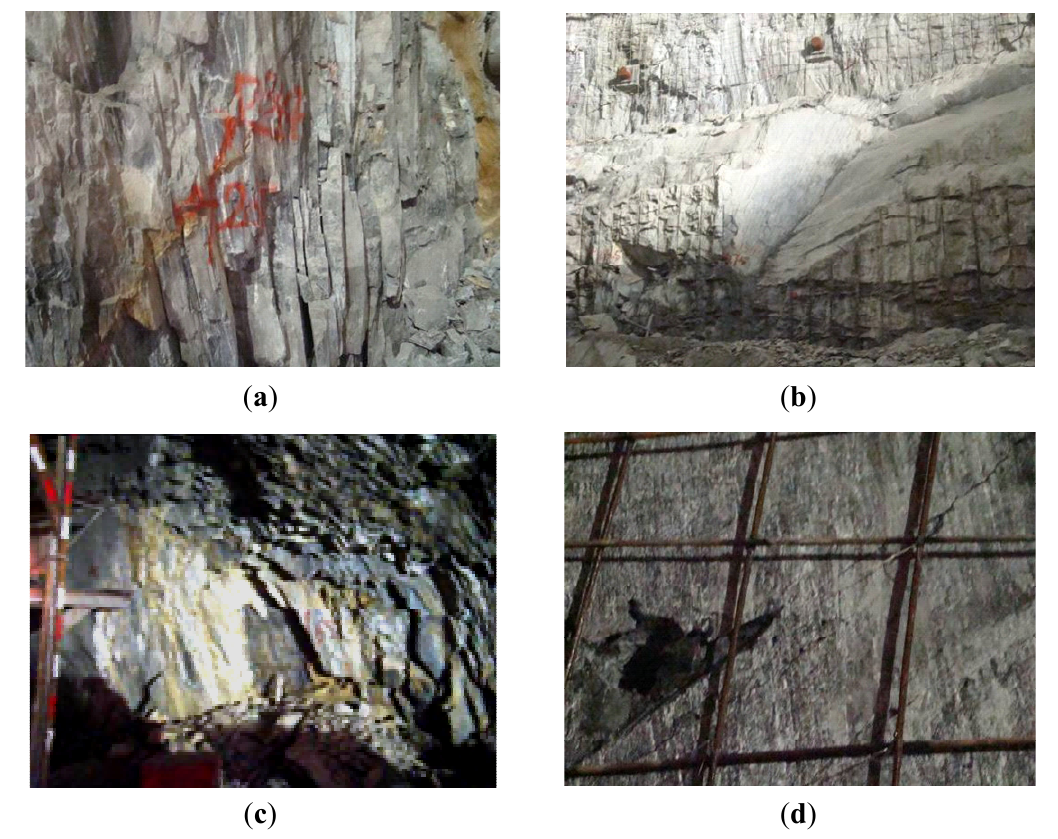
Figure 8. Typical failure modes of surrounding rock. ( a ) Stretch of rock strata at upstream side walls; ( b ) wedge slide at R0+275 of the downstream side wall; ( c ) Rock falls in the main transformation cavern; ( d ) tension-shear cracking at side